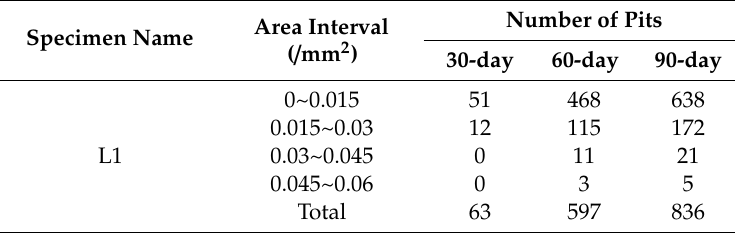
Table 5. Distribution statistics of pitting size of L1.